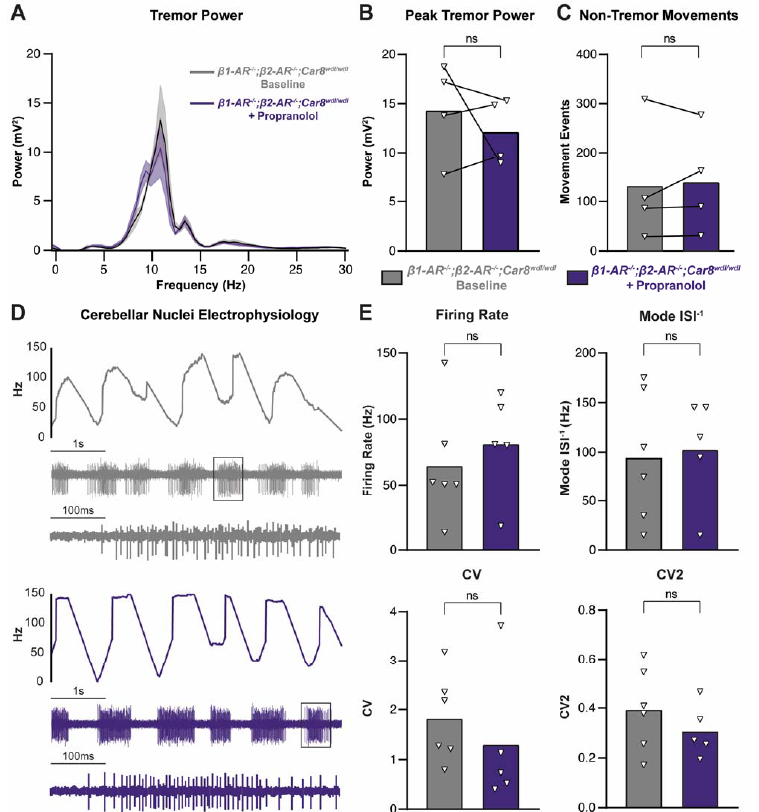
Figure 7. β 1 and β 2 adrenergic receptor function is required for propranolol to reduce Car8 wdl/wdl tremor. ( A ) Line graph depicting tremor power versus frequency in β 1 ‐ AR ‐ / ‐ ; β 2 ‐ AR ‐ / ‐ ;Car8 wdl/wdl mice before (gray, N = 4) and after (indigo, N = 4) propranolol treatment. The same color assignment for each group is maintained throughout the remaining figure panels (legend below panels B and C). ( B ) Quantification of peak tremor power in β 1 ‐ AR ‐ / ‐ ; β 2 ‐ AR ‐ / ‐ ;Car8 wdl/wdl mice, with lines connecting each subject’s before and after propranolol data points. Propranolol does not significantly reduce tremor in β 1 ‐ AR ‐ / ‐ ; β 2 ‐ AR ‐ / ‐ ;Car8 wdl/wdl mice. ns = not significant, p > 0.05. ( C ) Quantifications of non ‐ tremor movements show no significant difference between β 1 ‐ AR ‐ / ‐ ; β 2 ‐ AR ‐ / ‐ ;Car8 wdl/wdl mice at base ‐ line or after being treated with propranolol. ( D ) Representative raw electrophysiological traces of cerebellar nuclei neuron activity in β 1 ‐ AR ‐ / ‐ ; β 2 ‐ AR ‐ / ‐ ;Car8 wdl/wdl mice before (N = 2, n = 6) and after propranolol treatment (N = 2, n = 5). The line graph at the top for each condition represents the mean firing rate in Hz at each point in time for the 5 s spike traces shown below each line graph. Below